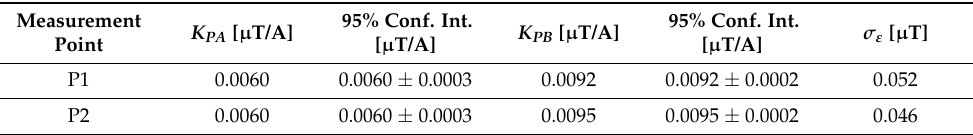
Table 3. Proportionality coefficients estimation for points P1 and P2, their 95% confidence interval, and residual standard